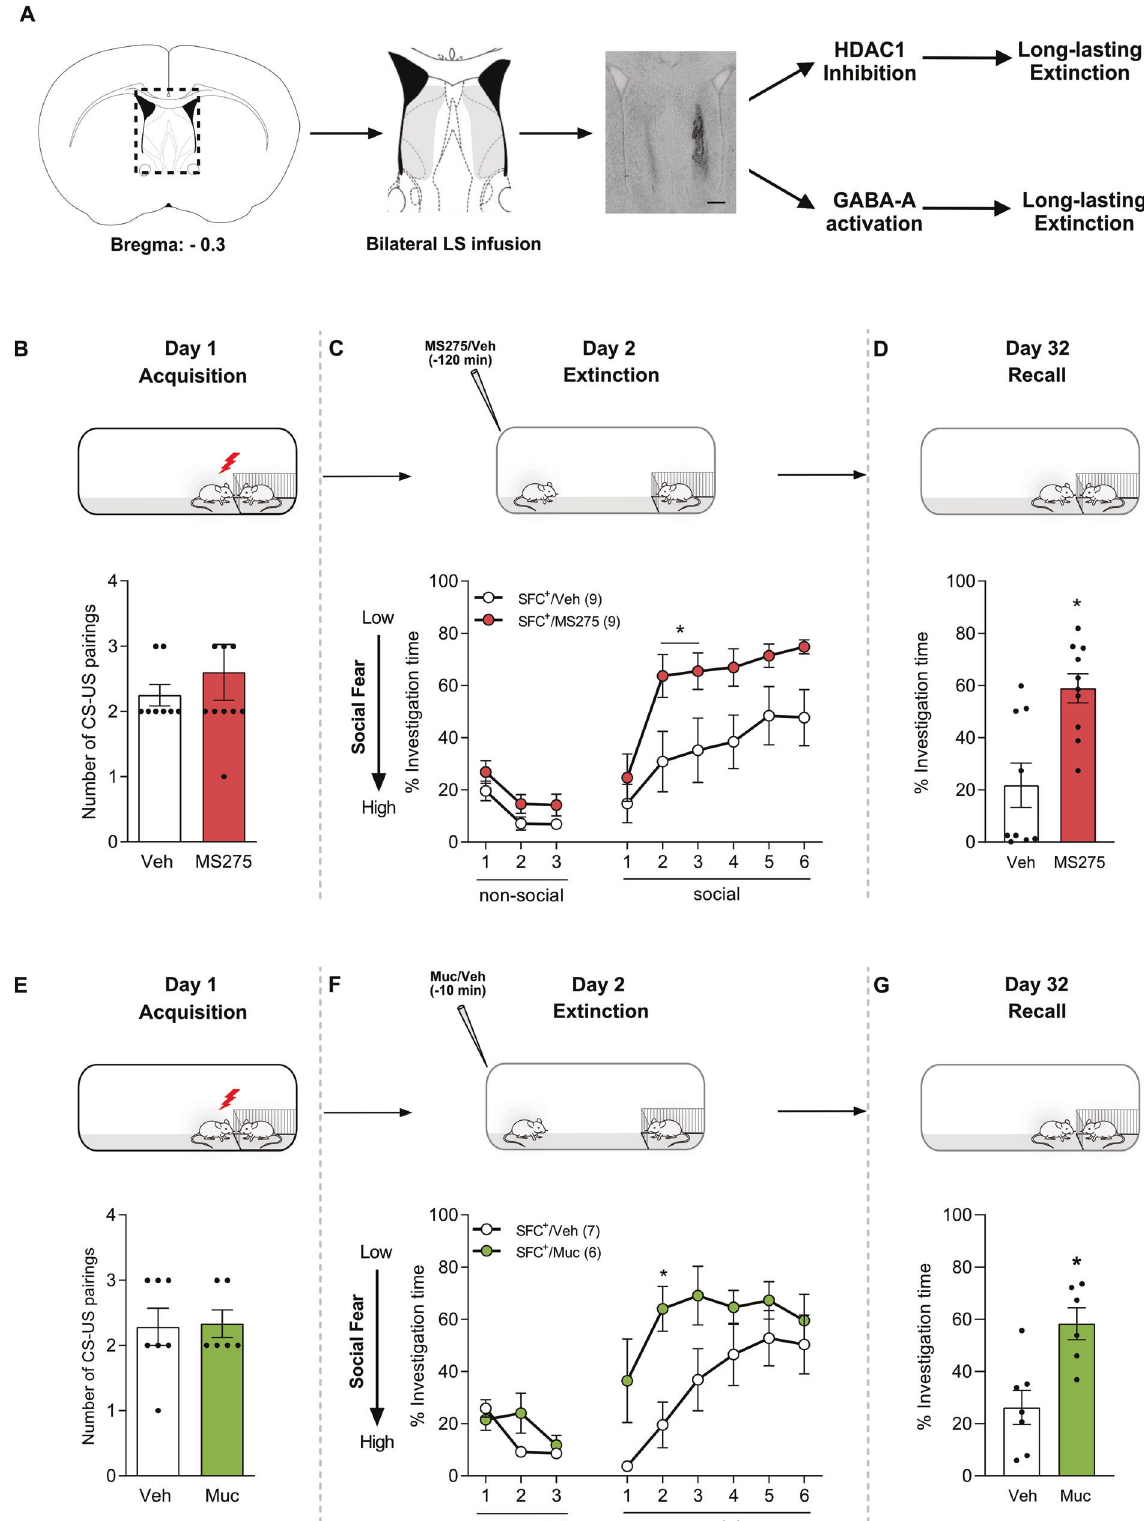
social fear extinction (Fig. 3F). Gabrb1 codes for the β 1 subunit of the GABA-A receptor, which is essential for assembling functional GABA-A receptors [35, 36]. Although various studies have proposed differential roles for GABA-A signaling in fear